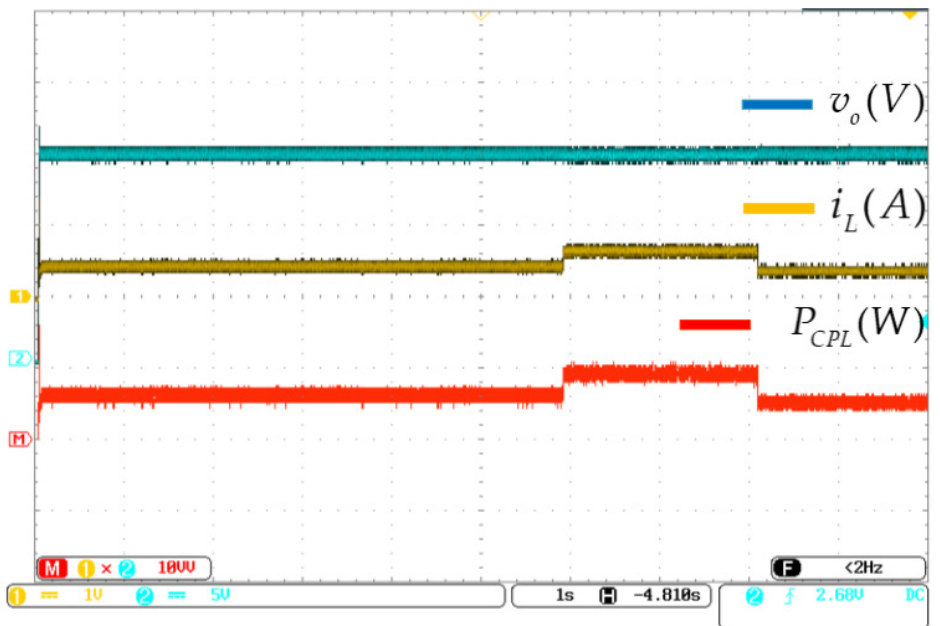
Figure 15. Experimental results: Time evolution of the output voltage and the output current against variable change in the CPL.